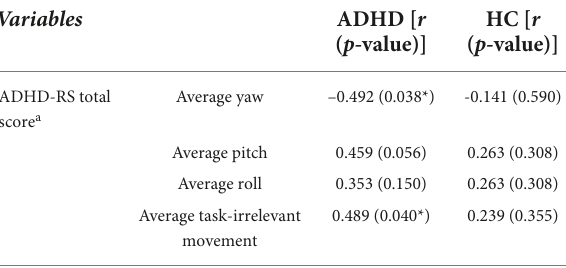
TABLE 2 Correlation analyses between head movement measurements averaged across all conditions, ADHD-RS total